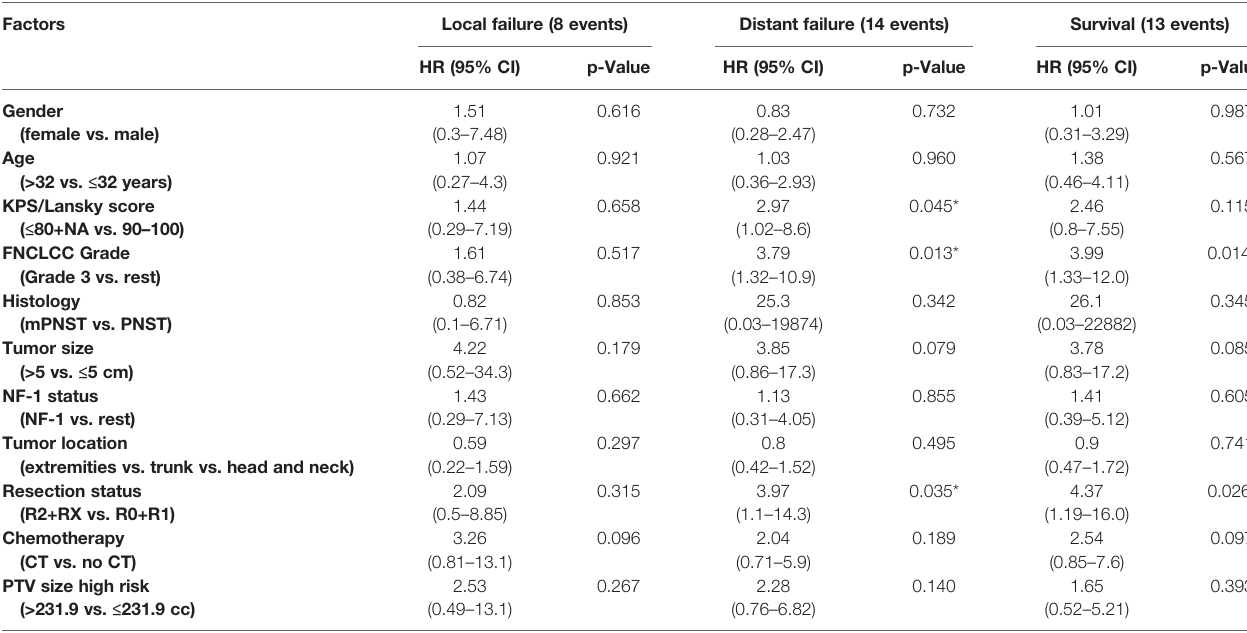
TABLE 3 | Univariate